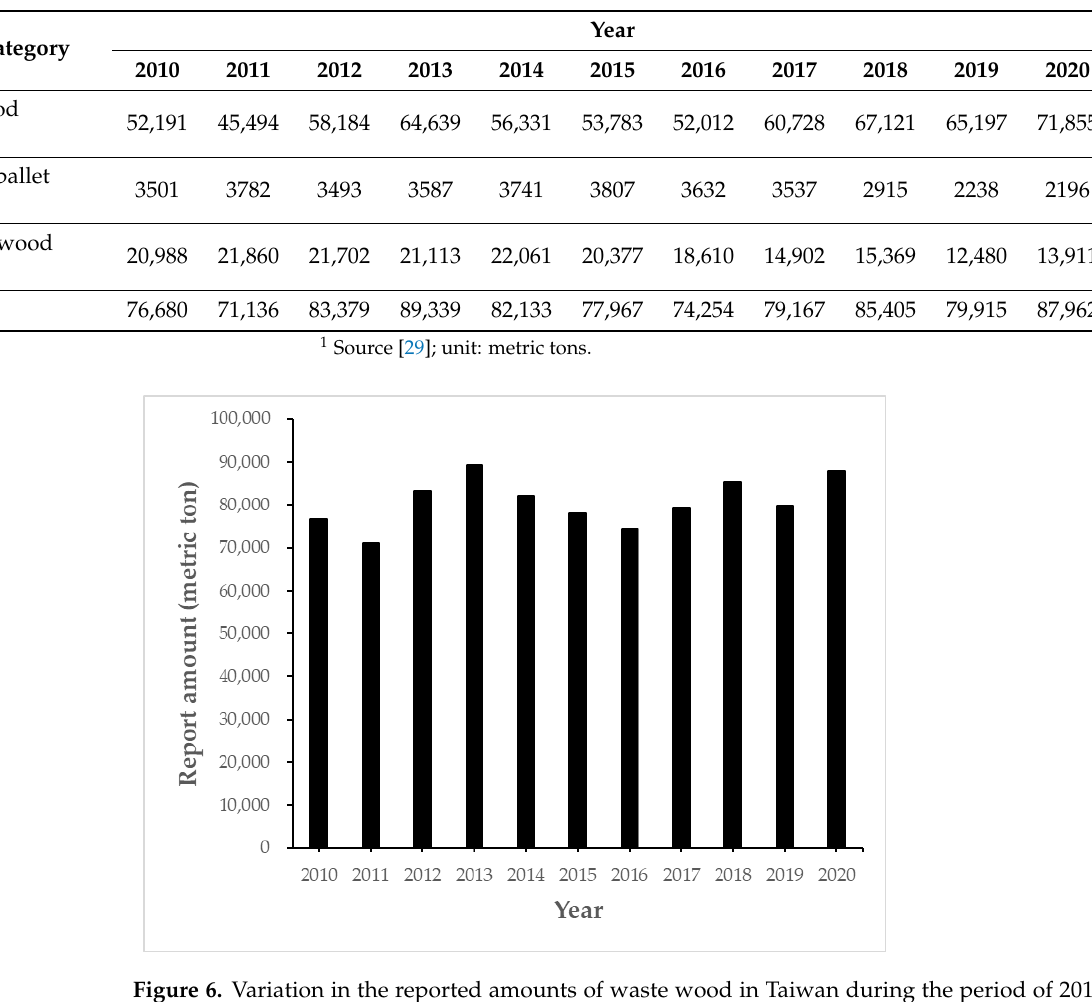
Table 5. Reported amounts of waste wood in terms of categories in Taiwan since 2010 1 .